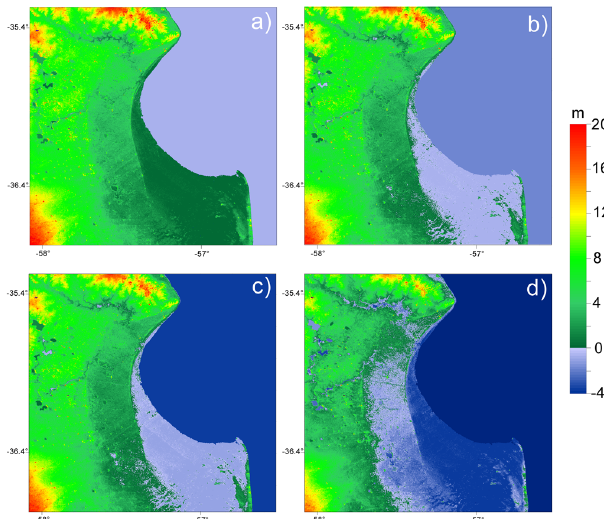
Fig. 8. (a) Digital Elevation Model of Samboromb´on Bay obtained by processing SRTM data. Flooded coastland expected in 2100 dur- ing a mean high tide level of 70cm with (b) scenario S 1 and (c) scenario S 2 , i.e., respectively 97cm and 120cm sea level higher than the present value. (d) Coastal flooding due to an extreme surge of 3.5m sea level combined with 50cm of RSLR (S 2 )